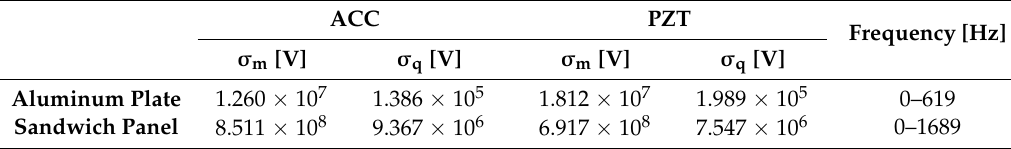
Table A3. Linear regression coefficient uncertainties; visual approach.